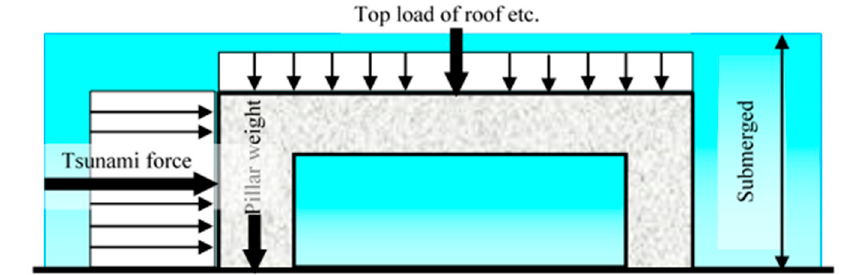
Figure 28. Illustration of the Ramen Gate Model.